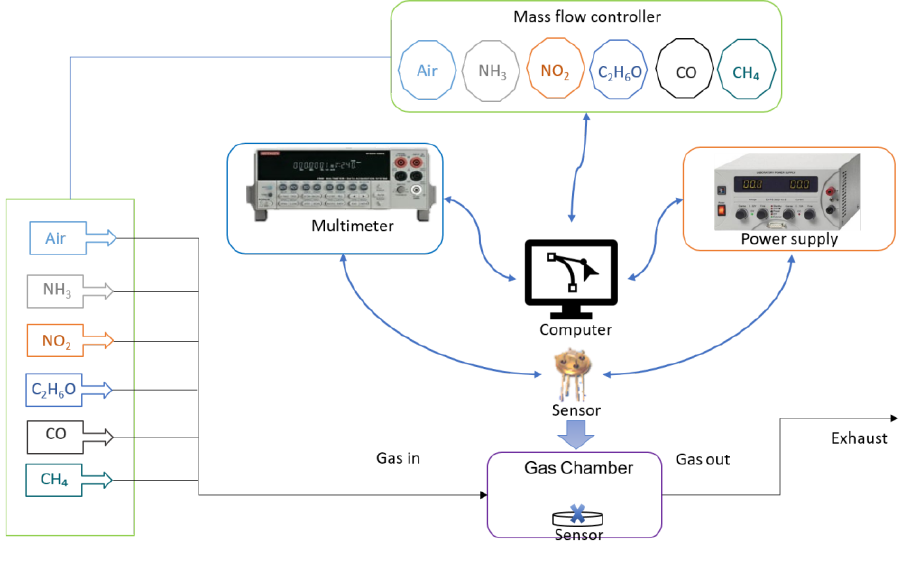
Figure 1. Schematic of gas-sensing system.